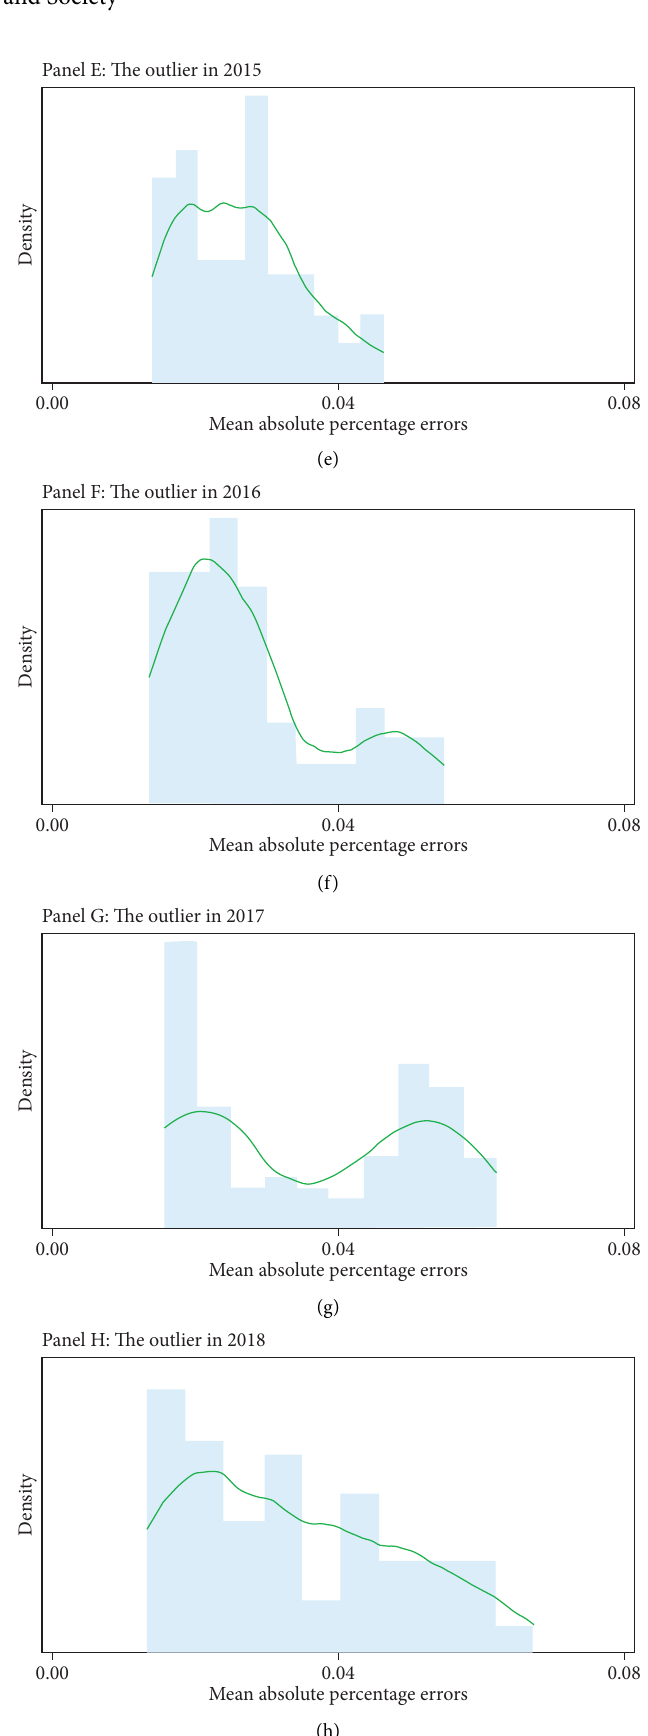
Figure 2: Te results from bootstrapping tests for NIPC-GM (1,